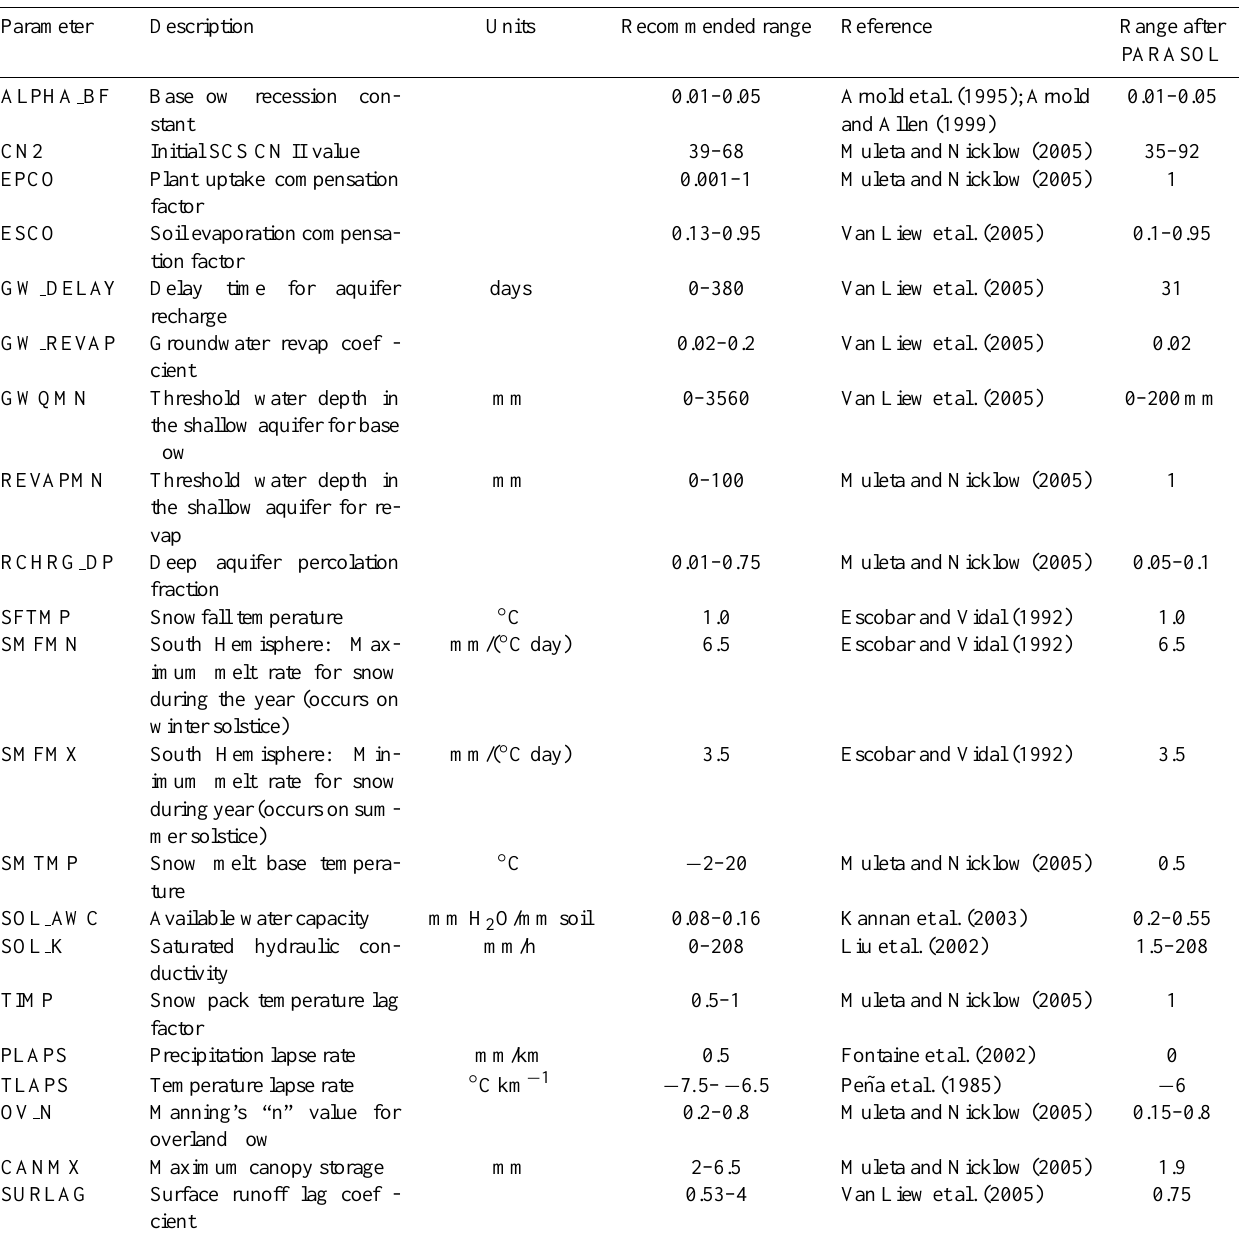
Table 9. Parameters involved in the computation of surface runoff in the Vergara